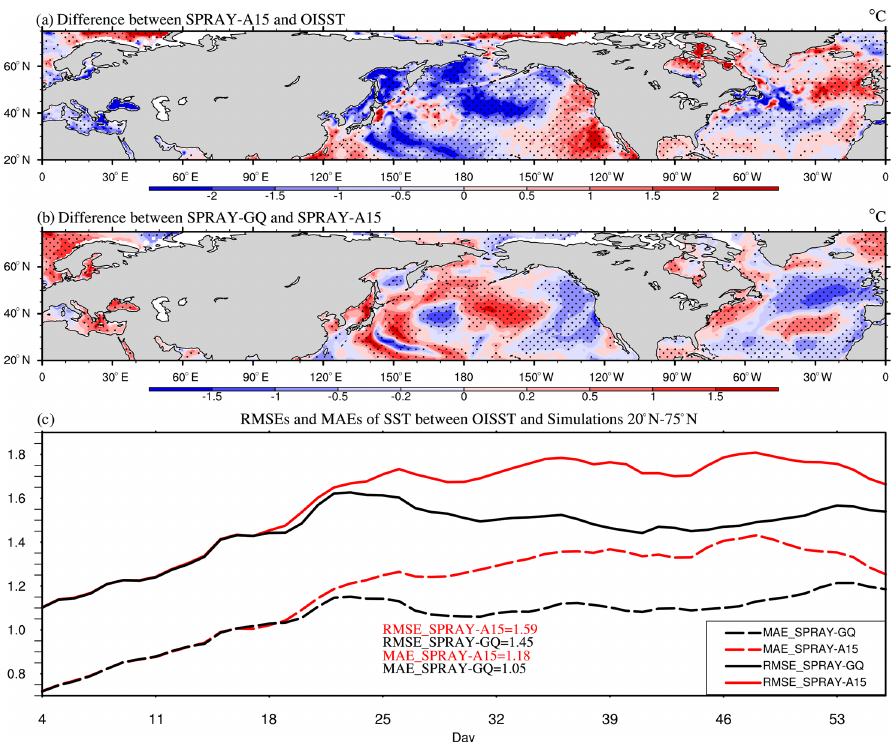
Figure 8. The same as Fig. 6, but for August–September 2018 in 0–360 ◦ E, 20–75 ◦ N.